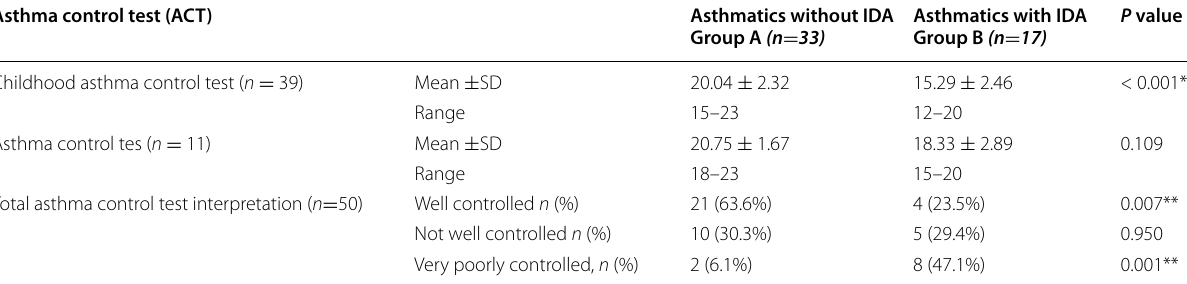
** p value< 0.01: highly